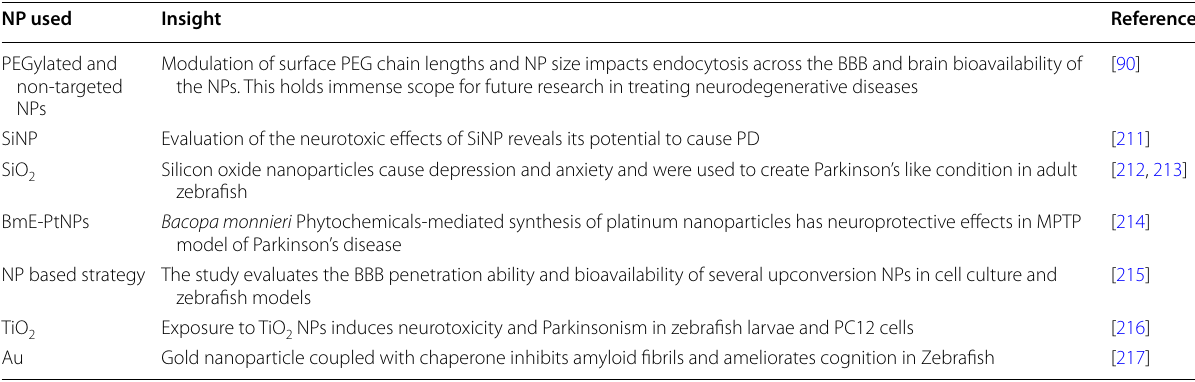
A list of studies on neurodegenerative diseases using nanoparticles in zebrafish